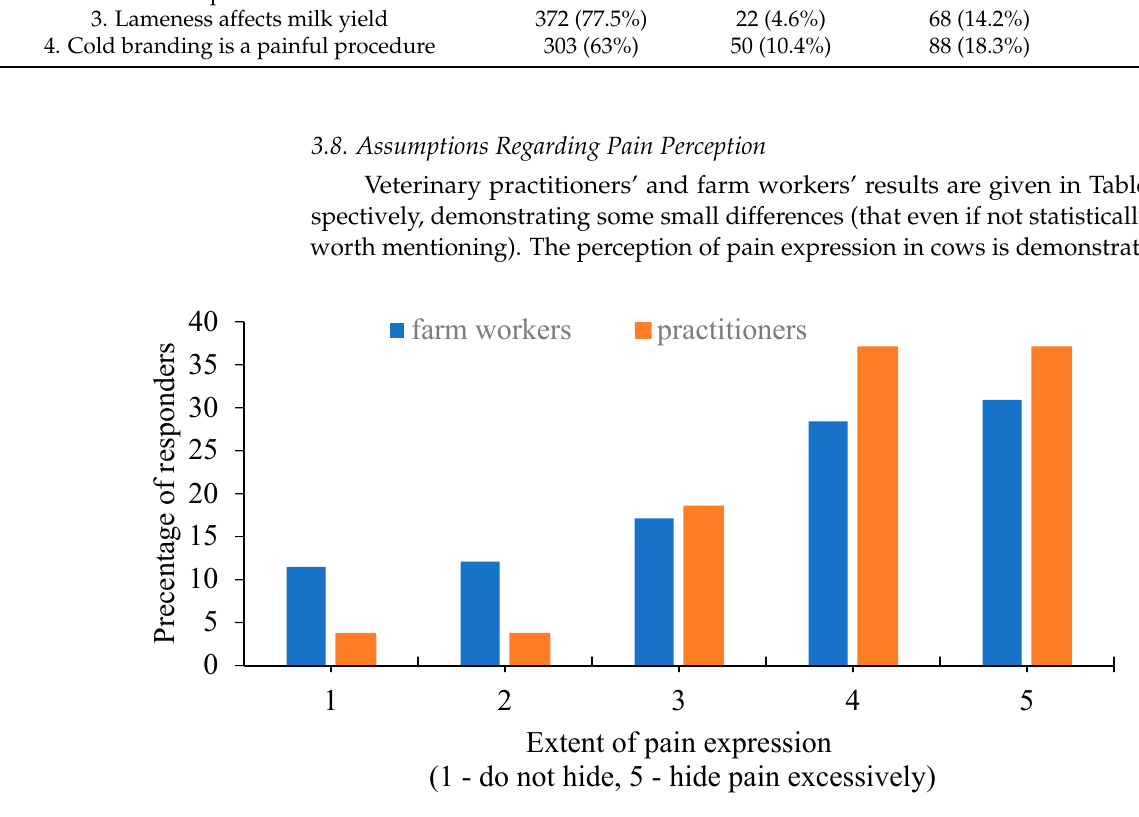
Figure 8. Farm workers’ ( n = 479) and practitioners’ ( n = 27) assessment of pain expression in cows. There were no statistical differences among groups.